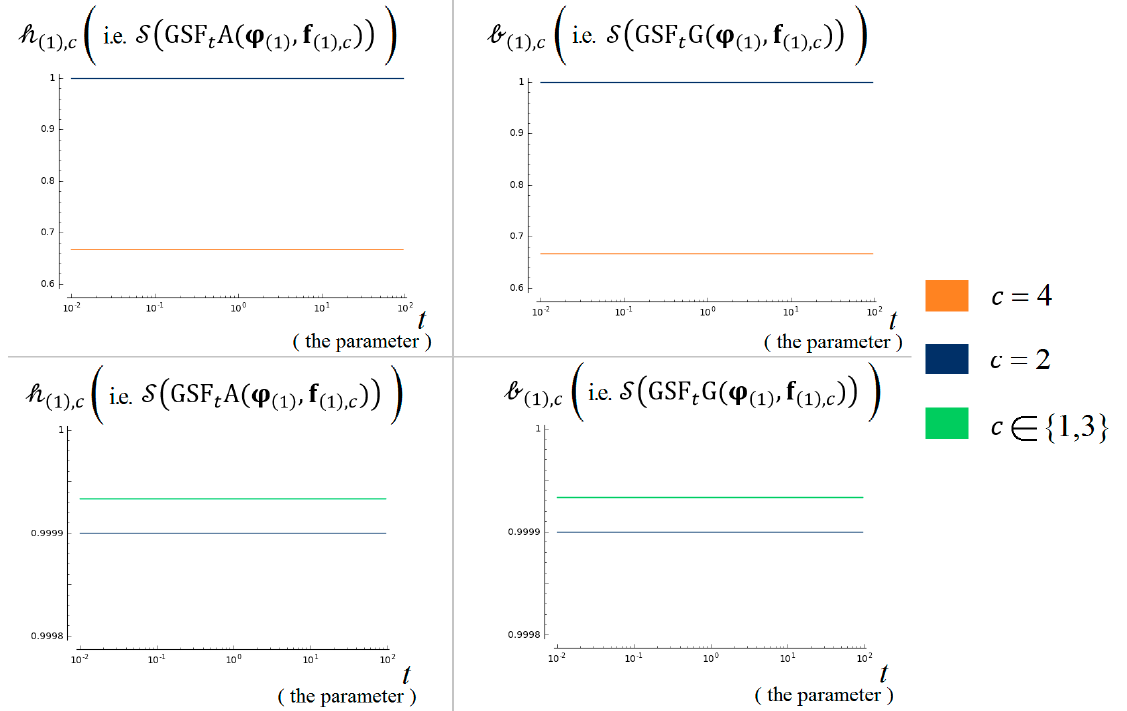
Figure 4. The results of our algorithms GSF (cid:3047) A and GSF (cid:3047) A for compliance of Test 1